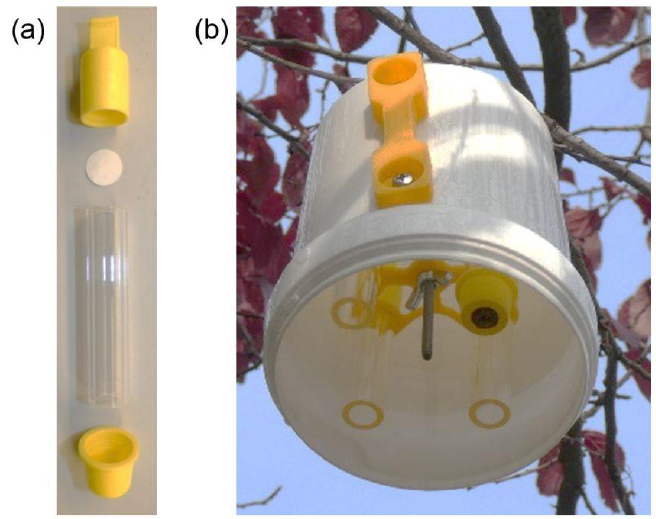
Figure 1. ( a ) Components of one sampling tube (yellow polyethylene caps, cotton pad, polymethac- rylate tube); ( b ) passive sampler with four sampling tubes fixed in common holder. late tube); ( b ) passive sampler with four sampling tubes fixed in common